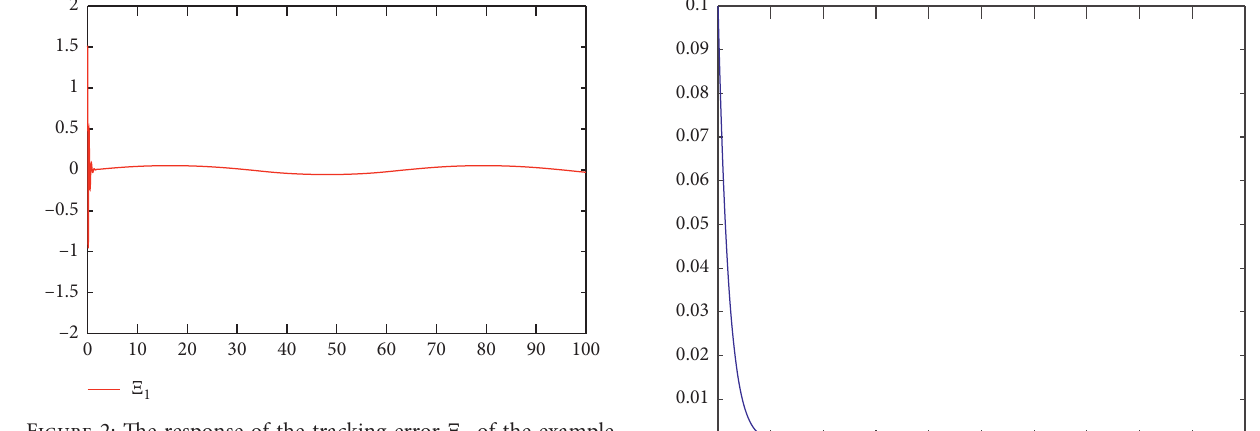
of the example. 1